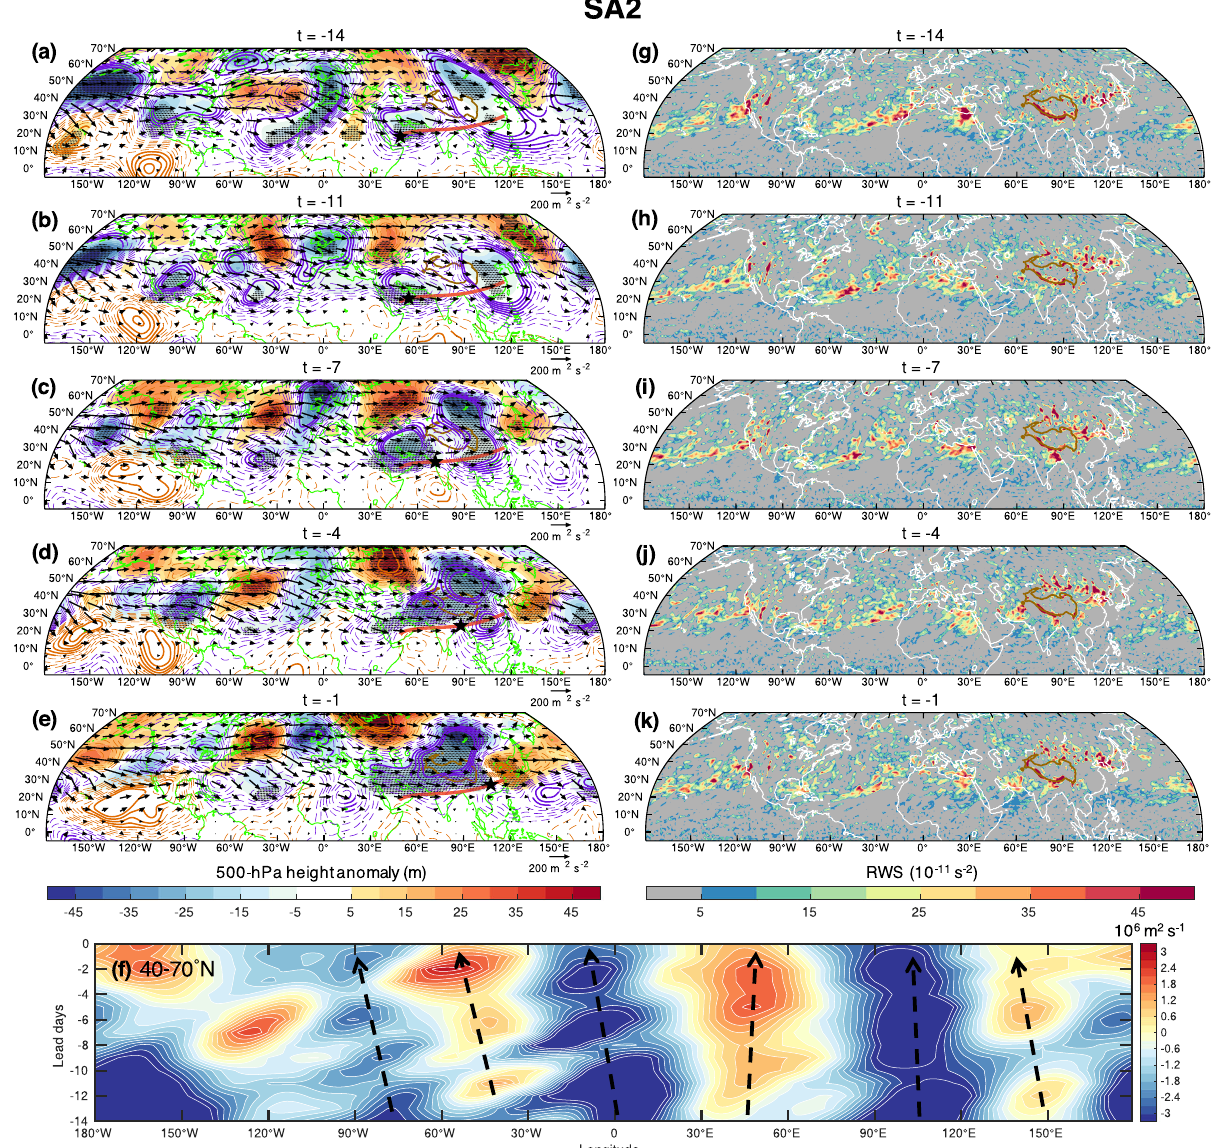
Fig. 7 Composites of wave activities and sources 2 weeks ahead of the rain belt events fed by the SA2 channel. a – k As in Fig. 6, but for the SA2 channel. The time-longitude plot in f shows the 200-hPa perturbation streamfunction (shading, unit: 10 6 m 2 s − 1 ) averaged meridionally at 40 –